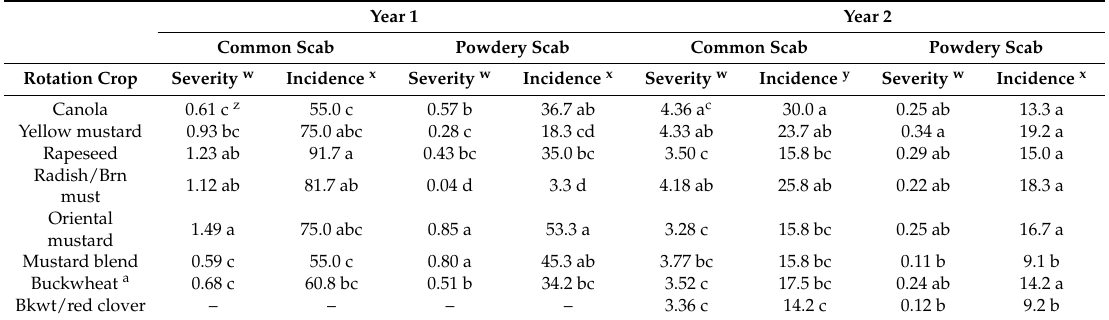
Table 3. Development of soilborne potato diseases at the Northern Aroostook site as affected by previous rotation crop in Year 1 and Year 2 of potato production.